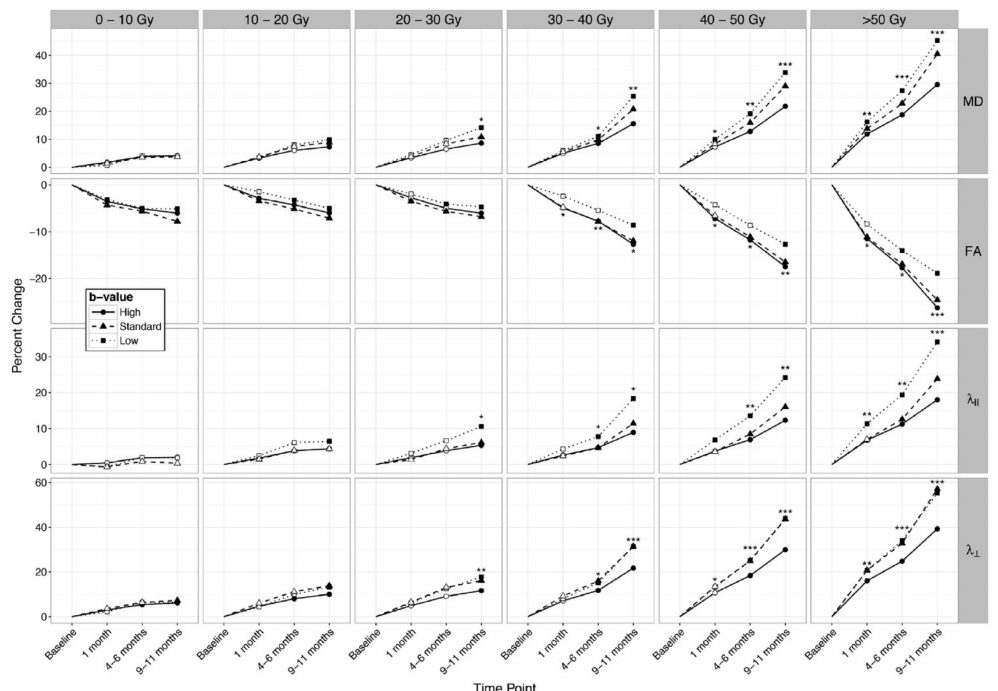
Figure 3. Percentage changes from baseline in MD, FA, AD ( λ (cid:107) ), and RD ( λ ⊥ ) over the time for dose-bins and different b-value measurements. All parameters show time- and dose-dependent changes. For MD, AD, and RD, the changes are most pronounced for measurements with small b -values, whereas for FA, the changes are most prominent at high b -values. Hollow points: non-significant changes, filled points: significant changes, *** p < 0.001, ** p < 0.01, * p < 0.05. Reprinted from Connor et al. [80] with permission from